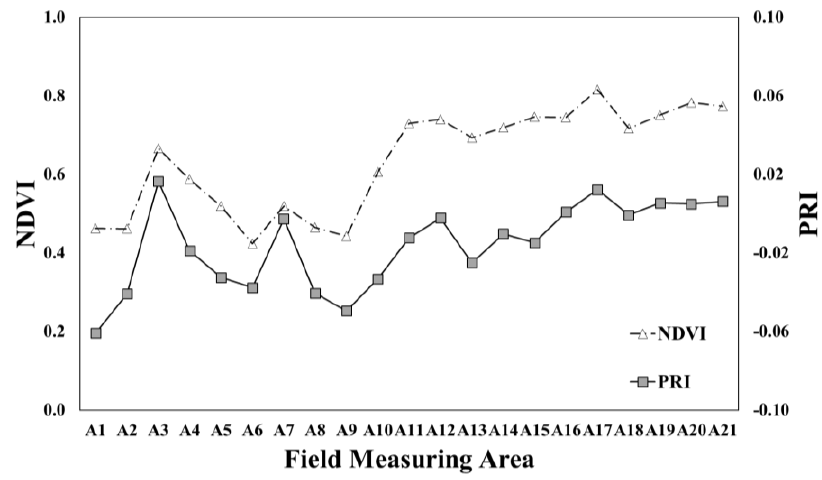
Figure 13. Comparison of NDVI according to growth conditions using UAV imagery.